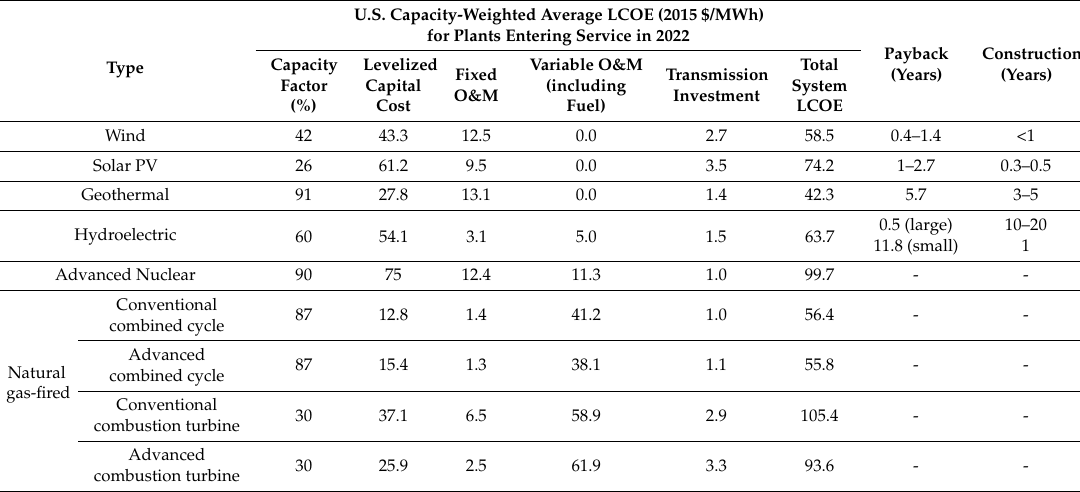
Table 5. Estimated LCOE for new generation resources, plants entering service in 2022